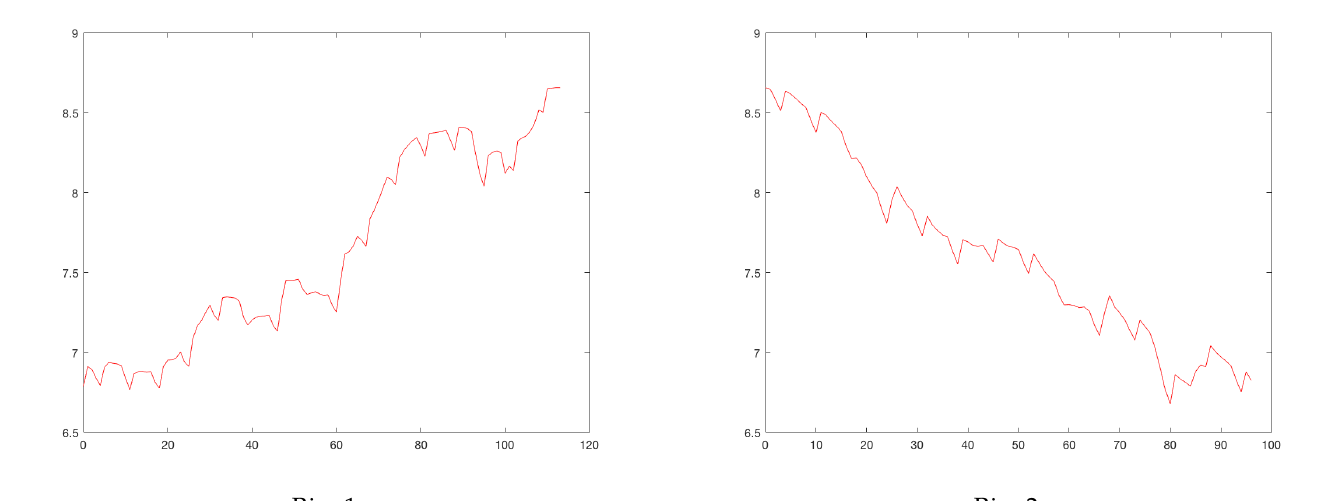
Figure A19. Mexico City’s rise and drop. Horizontal axis, days; vertical axis: logarithm of daily